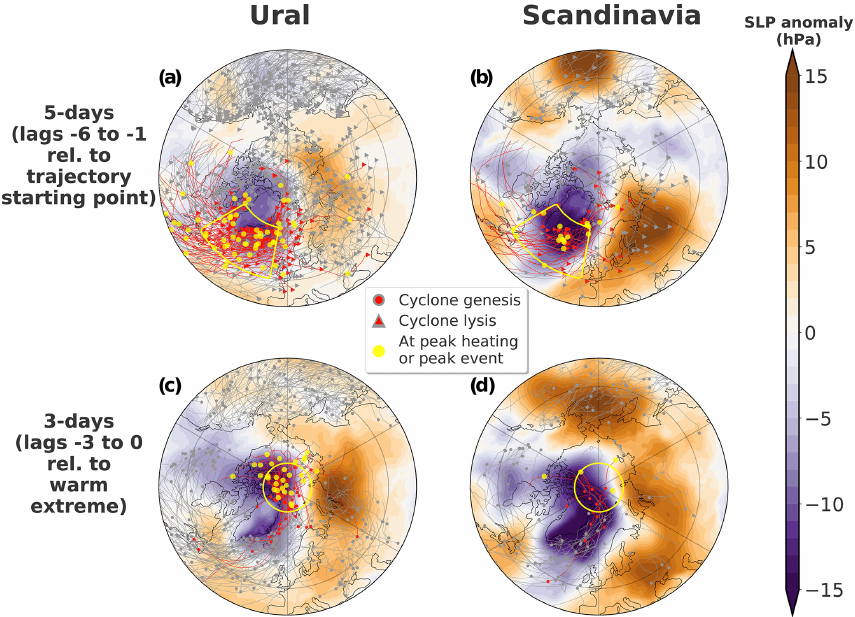
Figure 13. Cyclone track distribution around warm extremes related to Ural (left column) or Scandinavian (right column) blocks. (a, b) Cyclones observed within lags − 1 to − 6d relative to trajectory initialization (blocking region), shown for 30 Ural (a) and 10 Scandinavian (b) events, respectively. Tracks are colored red if the selected cyclone is both in temporal and spatial correspondence with the considered time period in the yellow sector (C; 50–70 ◦ N, 10–60 ◦ W). If there is only a temporal match, the cyclones are colored gray. Shading shows the SLP anomaly composite over these events at the case-defined peak of maximum heating within the main heating domain for blocking trajectories (for 29 Ural and 10 Scandinavian events in panels (a) and (b) , respectively; see also Tables S2 and S4 in the Supplement, Sect. S1). Yellow circles show the location of the red-colored cyclones at this peak of maximum heating. Red or gray solid triangles show the lysis of cyclones that cross or stay outside the chosen sector, respectively. (c, d) Same as in panels (a) and (b) but shown for cyclones observed up to 3d prior to the peak of each Ural (c) or Scandinavian (d) event, respectively, where the red coloring refers to cyclones that reside in the high Arctic ( ≥ 80 ◦ N, yellow latitude band at 80 ◦ N) within the time period considered. The SLP anomaly composite field and yellow circles for the red-colored cyclones are shown at the time of each warm event. Red and gray solid circles denote the genesis of cyclones that cross or stay outside the chosen sector,